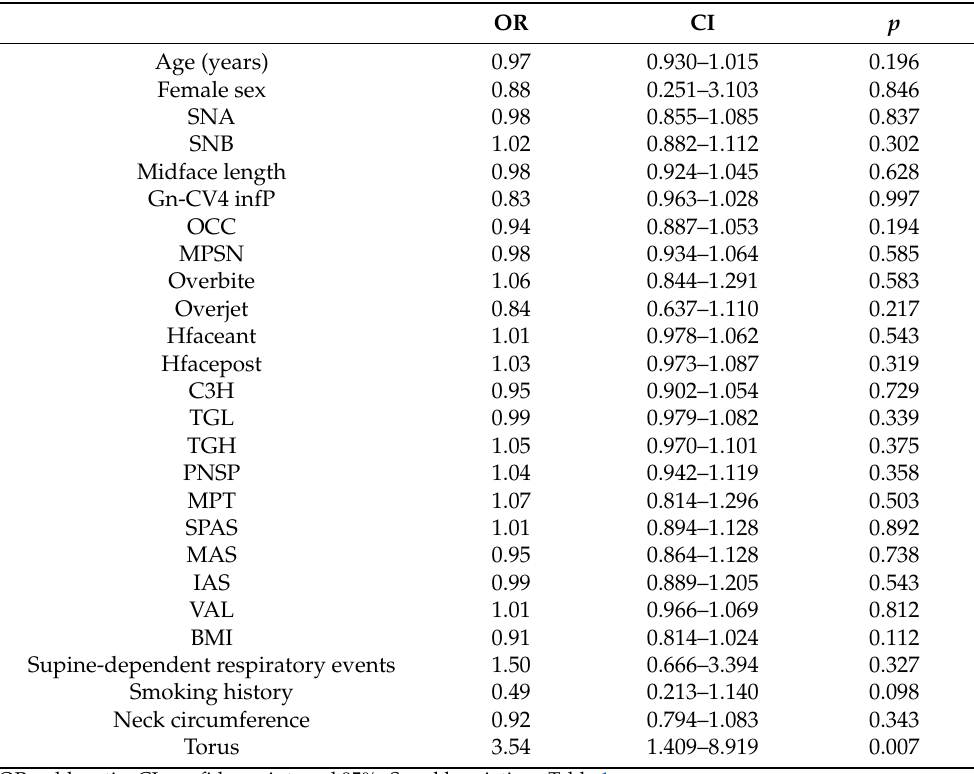
Table 5. Univariate analysis of the OR of the effectiveness of the MAD intervention.